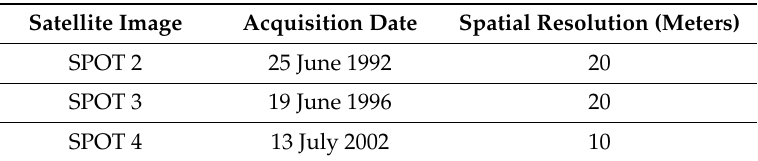
Table 1. Specifications of the SPOT images.